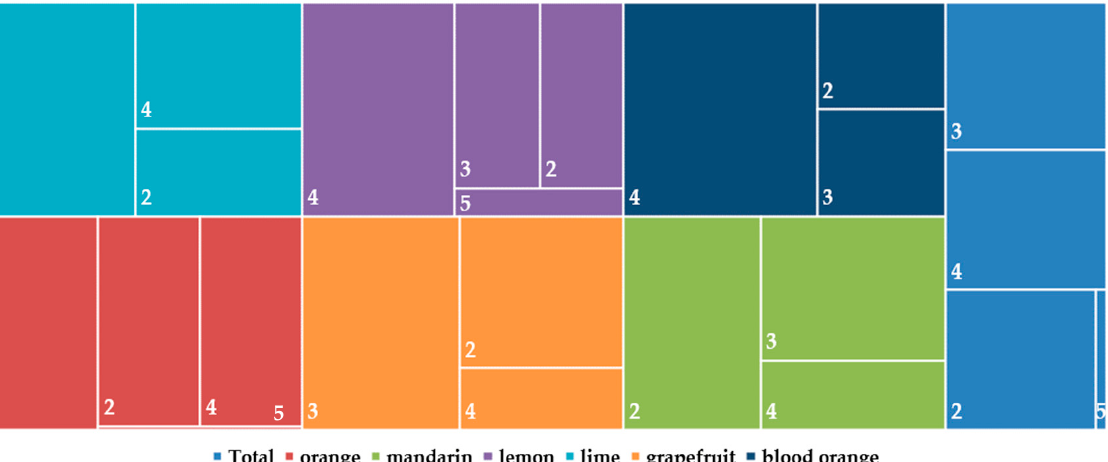
Figure 6. Tree map representation of the mixed infection types in the citrus hosts which were evaluated for the presence of five viroids. The colors of the boxes reflect the six specific surveyed hosts and the total sum of the samples. The numbers of the detected viroids (mixed infection type) are given inside boxes (2 = infection with two viroids, 3 = infection with three viroids, etc). The size of the boxes is proportional to the percentage of the infection types in each category.